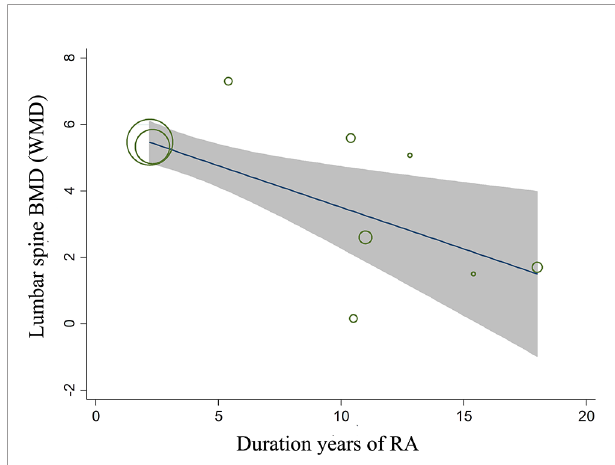
FIGURE 5 | Meta-regression analysis between the duration of RA and the effect of denosumab on the percent changes in lumbar spine BMD.